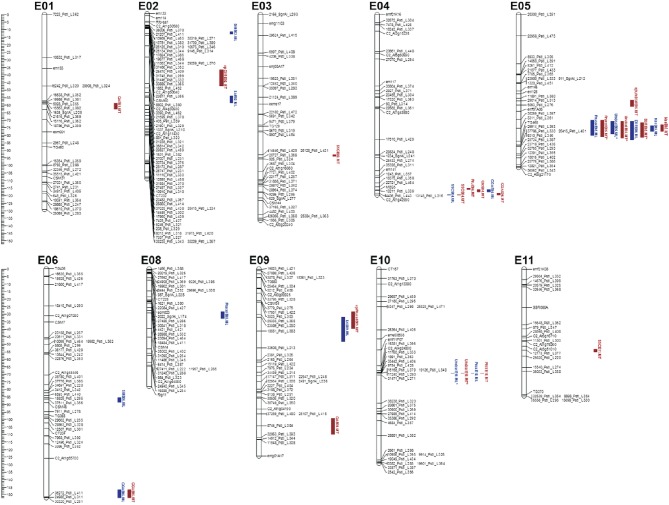
Eggplant linkage map with graphical representation of the QTL detected. Marker names are shown to the right of each chromosome, with map distances (in cM) shown on the left. Map positions of the QTL identified on each chromosome (or LG) are also given on the right. The length of the vertical bars represents the confidence interval of the QTL (LODmax−1 interval). QTL shown in blue were detected only at ML, and those in red only at MT. Epistatic interacting QTL are indicated by the prefix ^ where the QTL was recognized by MapQTL software.